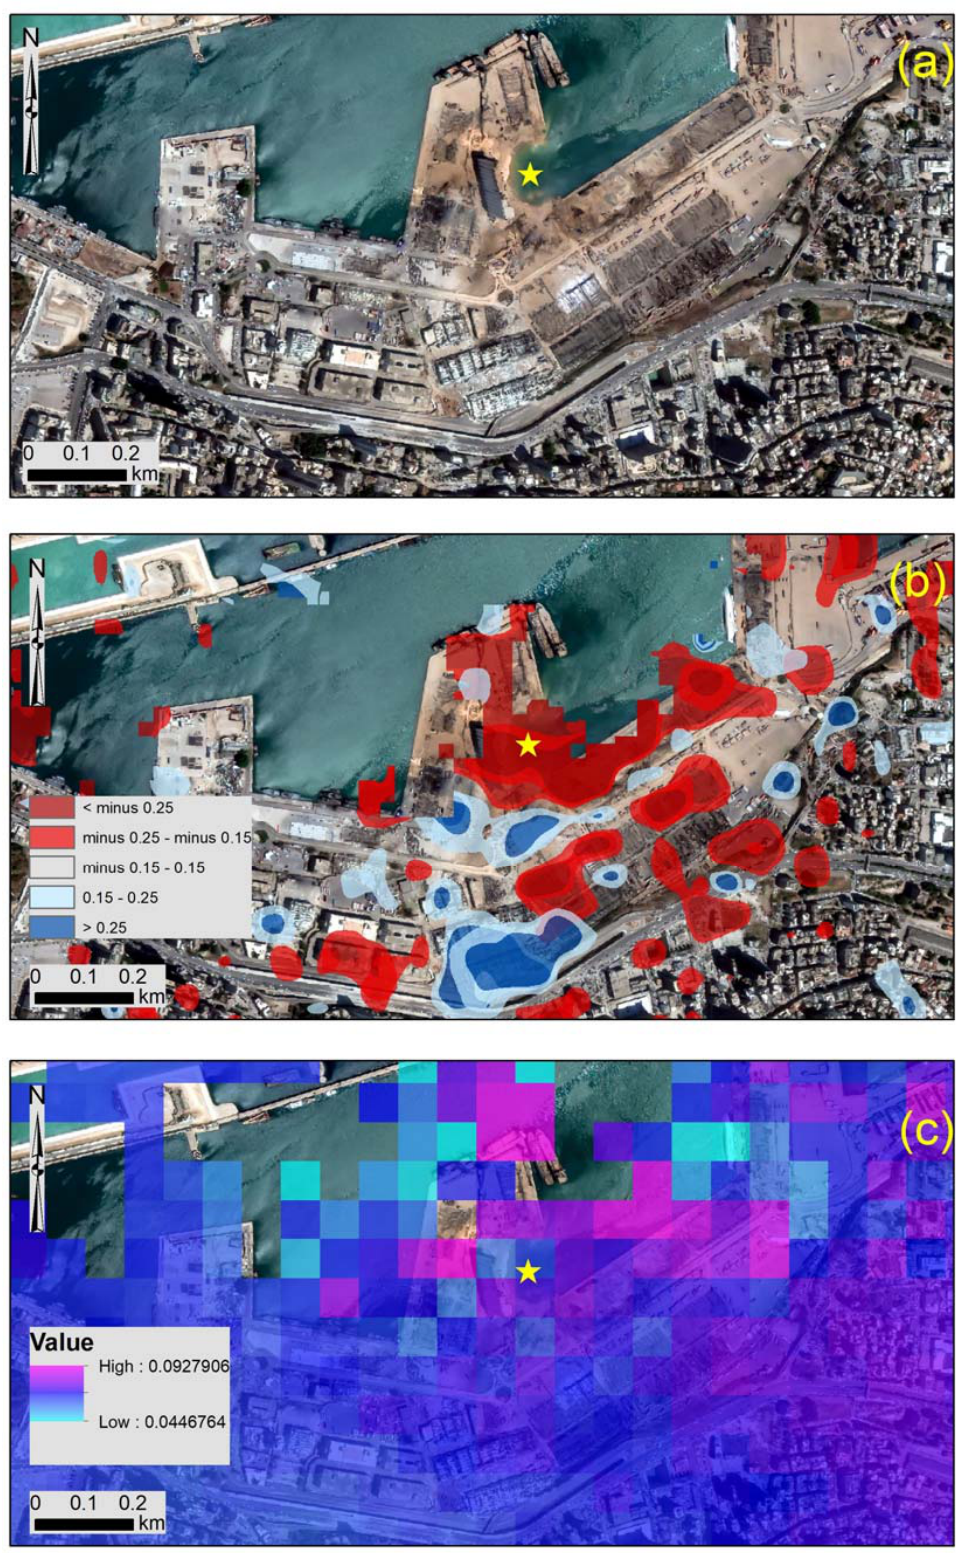
Figure 13. ( a ) High ‐ resolution WorldView ‐ 2 image taken some hours after the exposition over the harbor of Beirut. The blast site is indicated with a yellow star. ( b ) Change detection as generated from the VV and VH log differences of the Sentinel ‐ 1 image and ( c ) the InSAR analysis (LOS of the descending orbit images) over the area. The location of the blast size is shown with the yellow star.